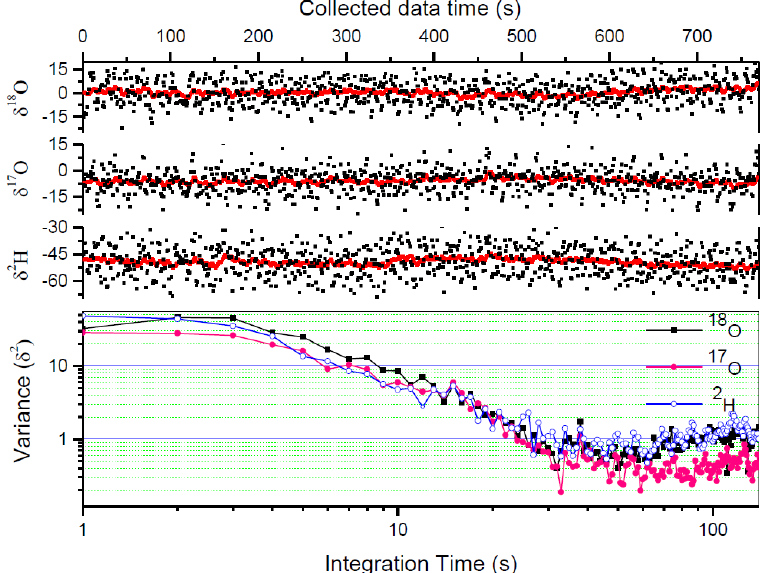
Figure 6. Measurement results of a bottled water (Vittel, France). The upper three panels show raw measurement of the  -value for 18 O, 17 O, 2 H (dots) and the corresponding Kalman filter output for a q-value of 800 (lines). The Allan variance plotted in the lower panel shows an optimal averaging time of ~30 s for the present IRLS